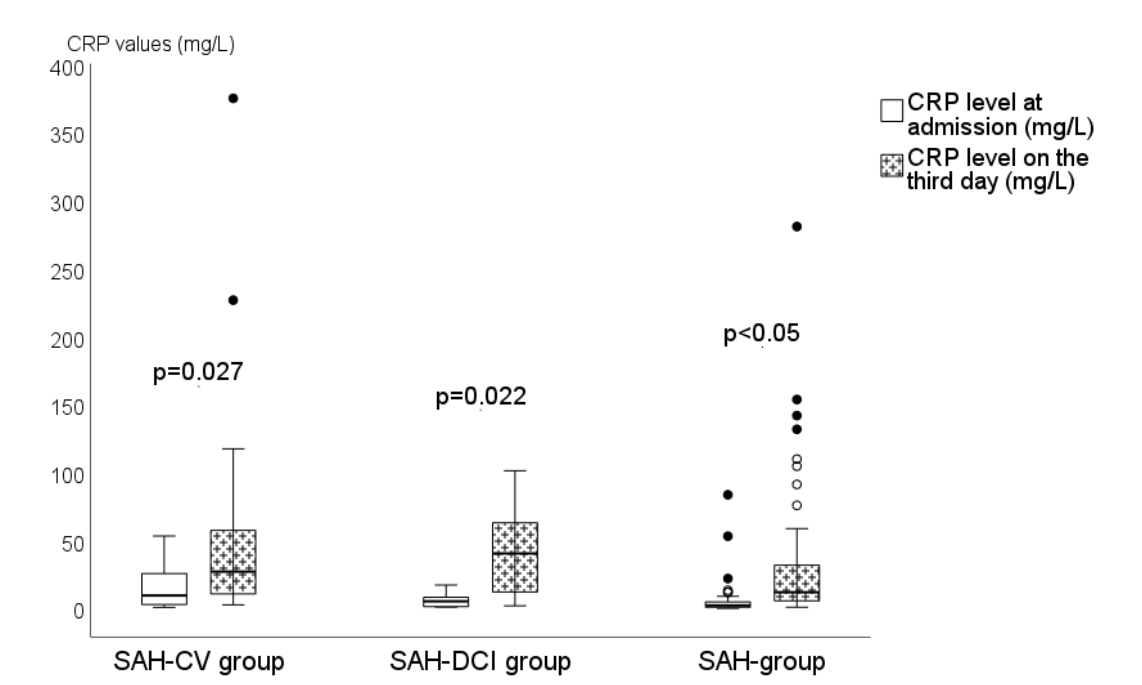
Figure 2. Rise of CRP between all three groups. Plasma levels of C-reactive protein at admission and on the third day in patients of SAH-CV group (patients with CV and CV progression to DCI as a consequence of undiagnosed/untreated/resistant to treatment CV), SAH-DCI (patients with confirmed DCI without previously diagnosed CV), and SAH group or controls (patients without CV and DCI). CRP—C-reactive protein; mg—milligram; L—liter. Data presented as median. Black and white dots—outliers in the data.